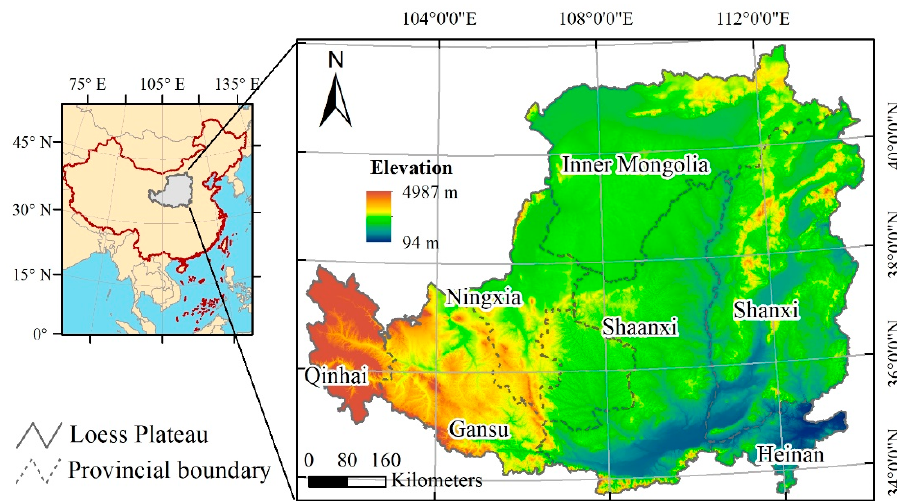
Figure 1. Geographic location of the study area.